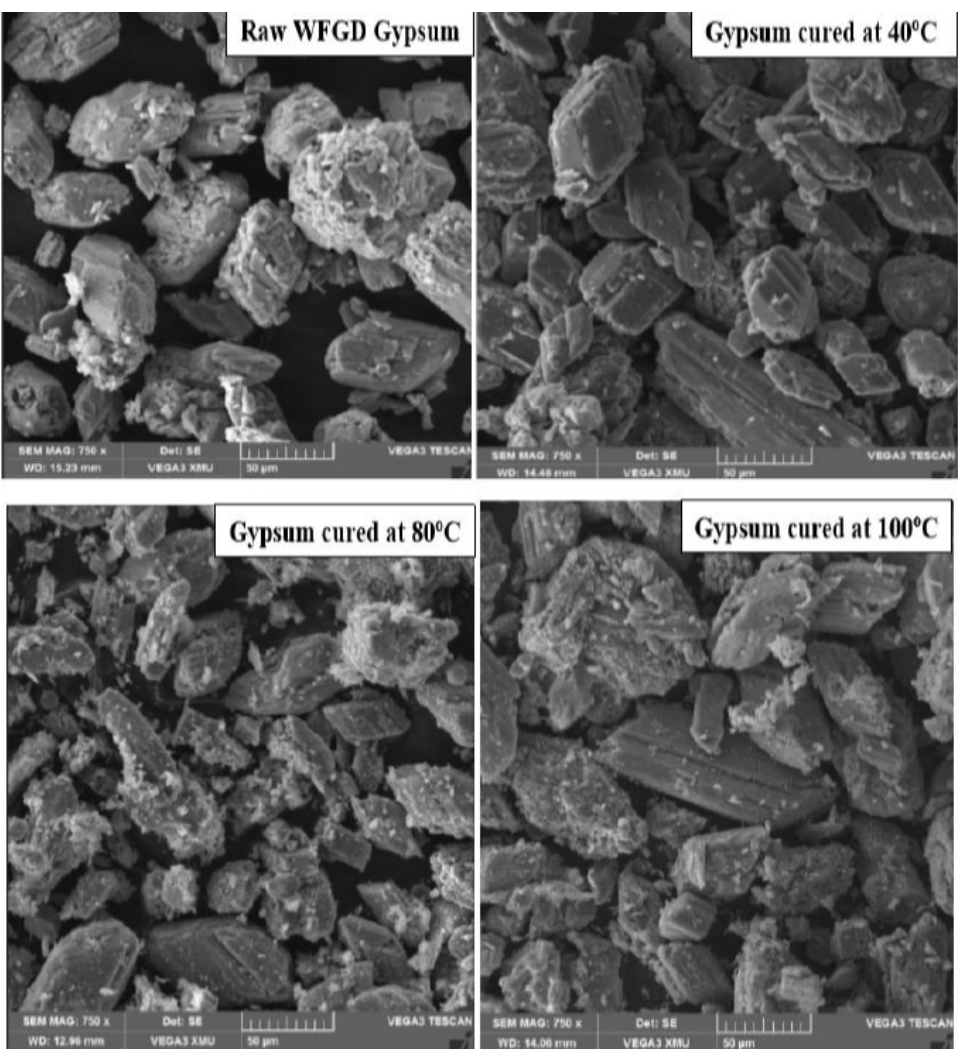
Figure 15. SEM analysis of WFGD gypsum bricks cured at various temperatures.